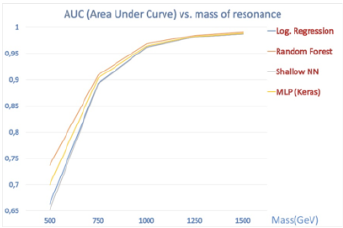
Fig. 2 . AUC vs mass of the signal ( 𝑡𝑡̅ resonances) [10]. NN: Neural Network; MLP (Keras): MultiLayer